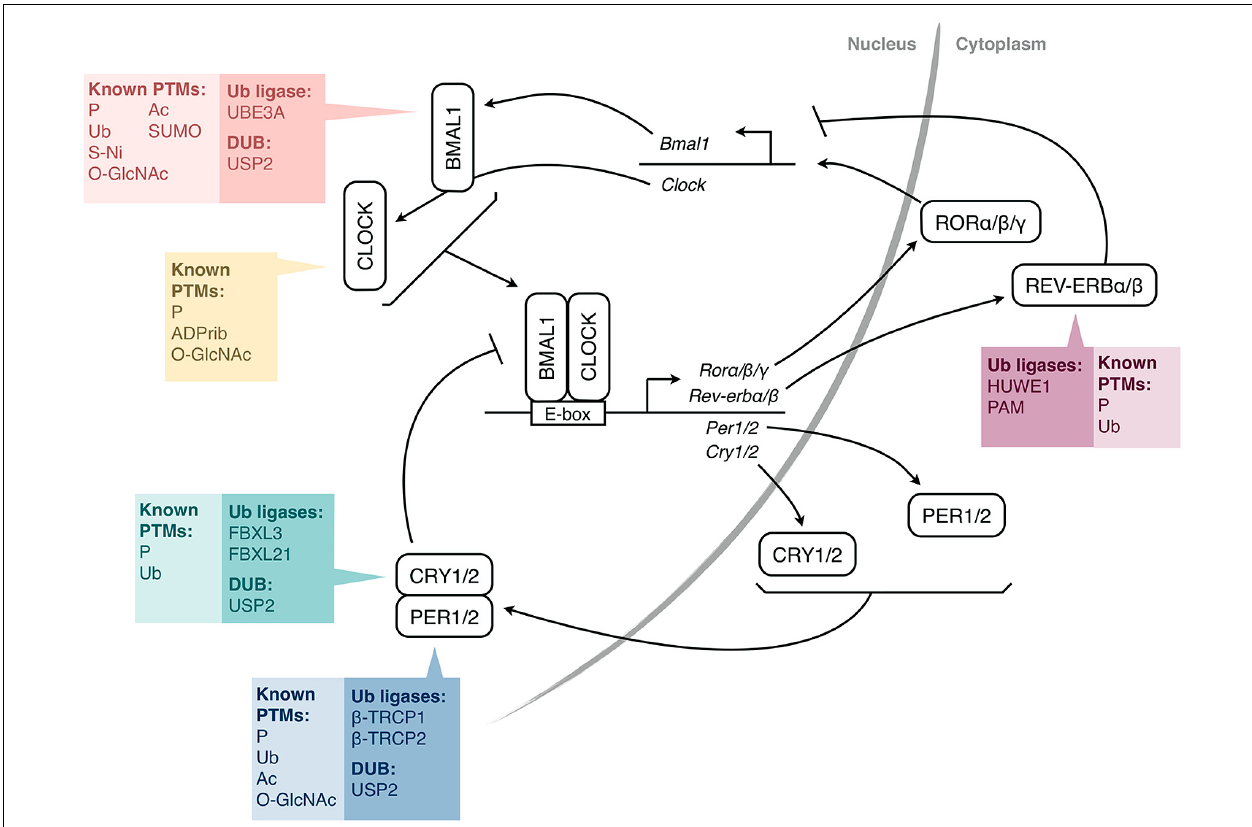
modifications (PTMs) that have been identified so far, as well as the ubiquitin-modifying enzymes shown to be involved (HUWE1, PAM, β -TRCP1/2 are also called ARF-BP1, MYCBP2, FBW1A/B, respectively). For simplicity, a single box per protein is shown, irrespective of the subcellular localization of the PTMs. P, phosphorylation; Ub, ubiquitination; Ac, acetylation; SUMO, SUMOylation; O-GlcNAc, addition of β - D - N -acetylglucosamine; S-Ni, S-nitrosylation; ADPrib, ADP-ribosylation; PER, Period; CRY, Cryptochrome; ROR, Retinoic acid receptor-related orphan receptor; DUB, deubiquitinating